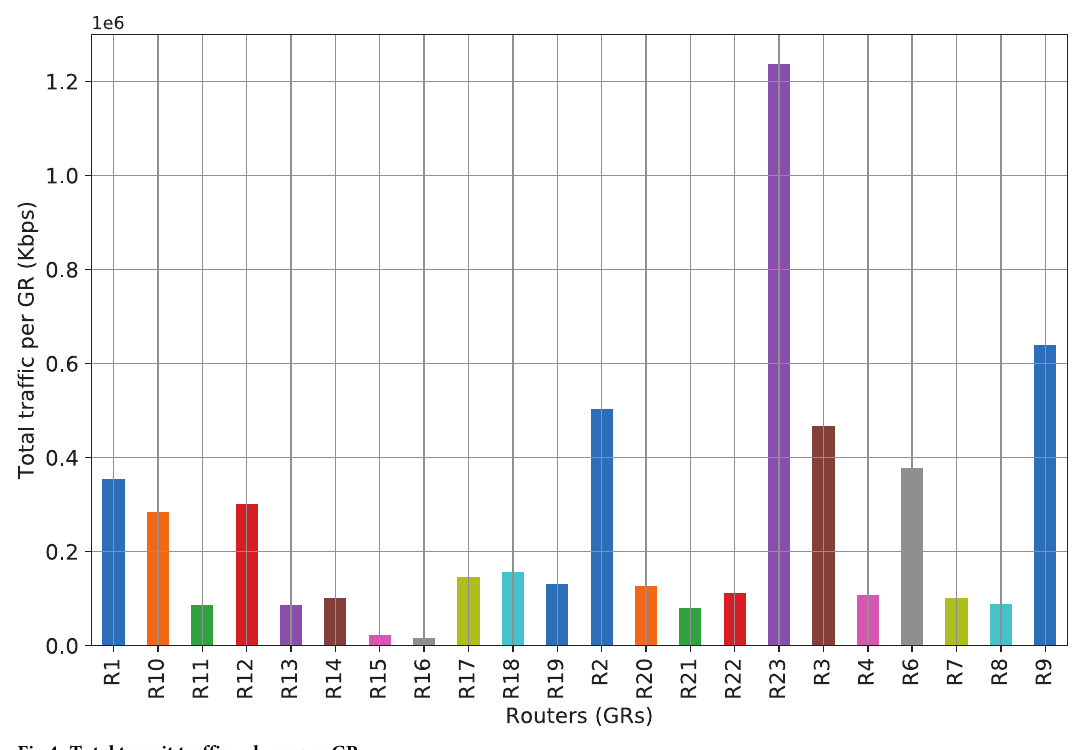
Fig 4. Total transit traffic volume per